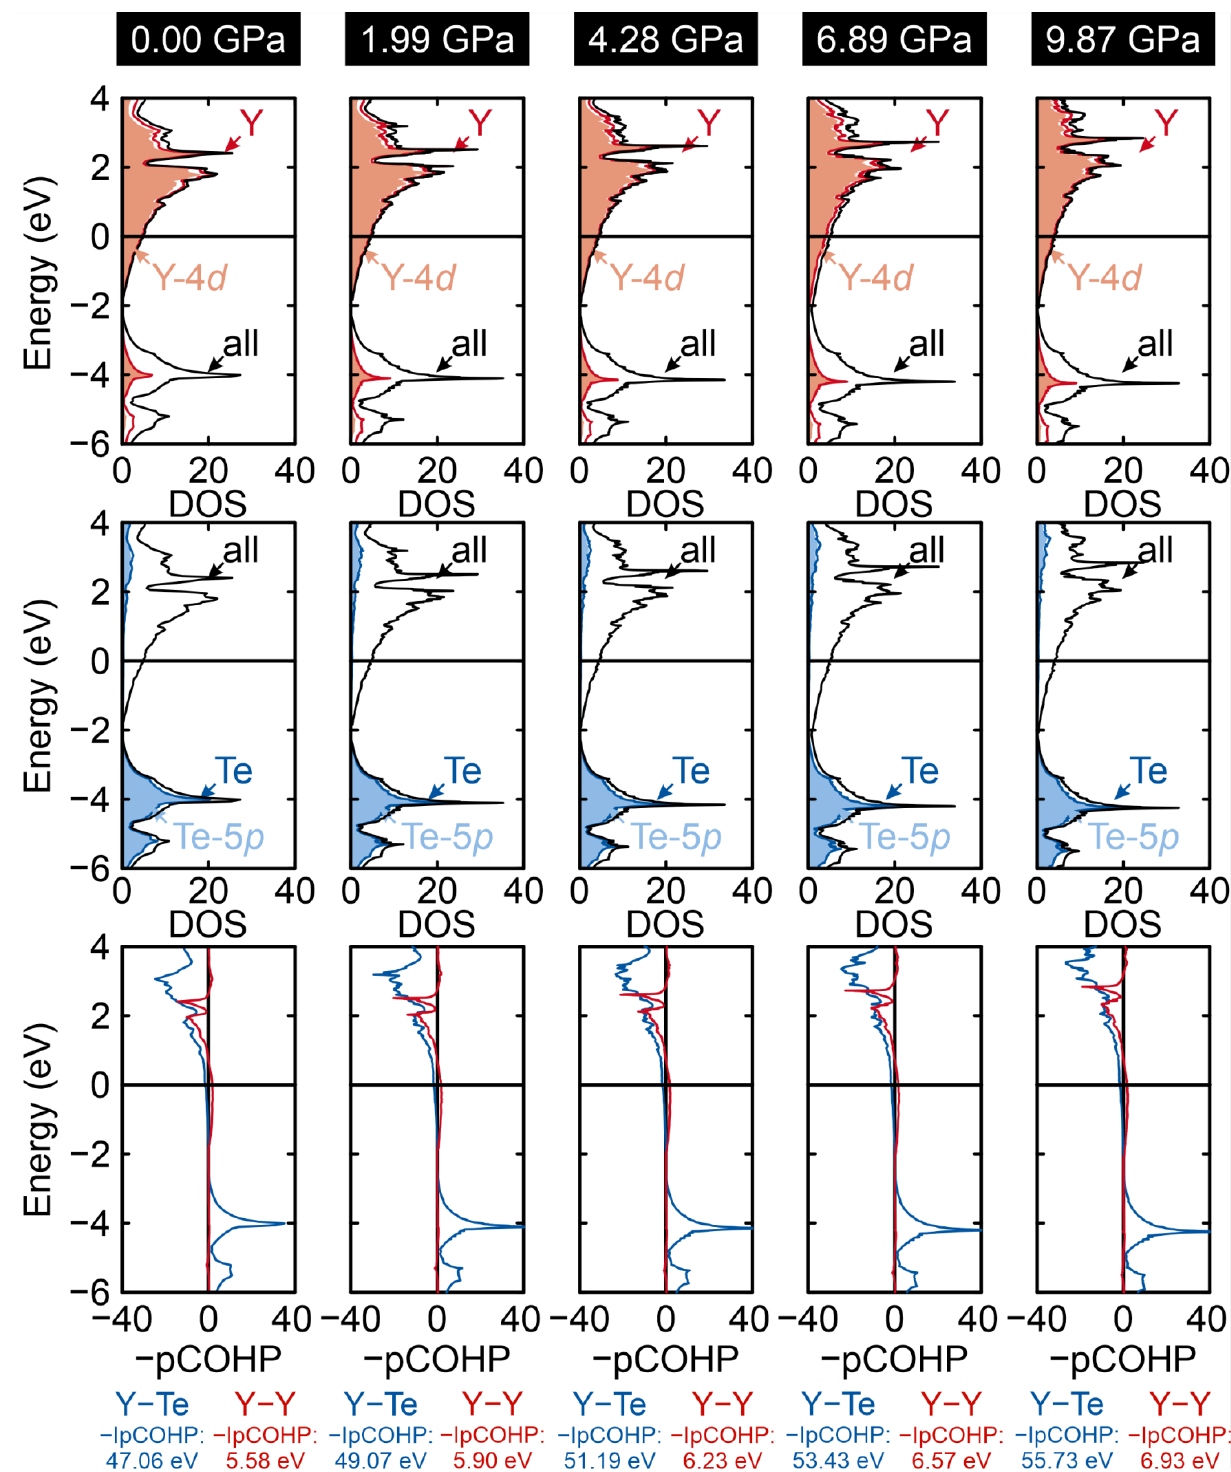
Figure 4. Pressure-dependent density-of-states (DOS) curves and projected crystal orbital Hamilton populations ( – pCOHP) of the rock-salt-type YTe. The Fermi levels, E F , are indicated by the black horizontal lines, while the cumulative – IpCOHP/cell values (see main text) are shown below the corresponding – pCOHP diagrams. Please note that the respective labels were located at the same relative positions within all the DOS diagrams so that the pressure-induced changes in the DOS curves could be recognized by inspecting the environments of the corresponding labels.